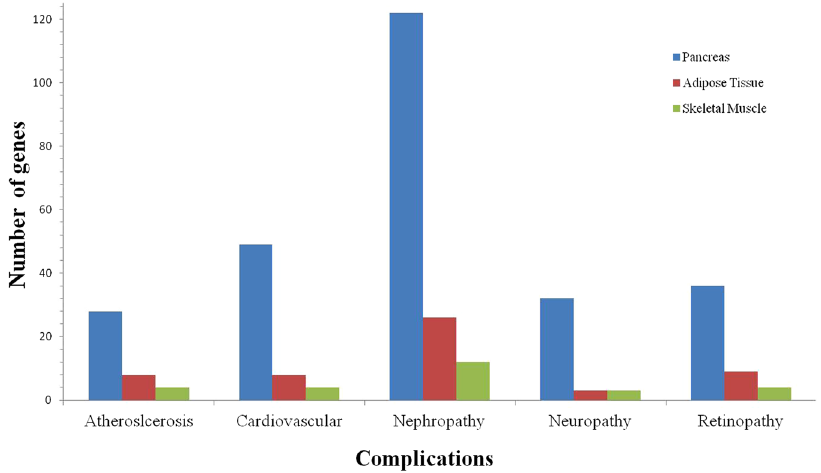
Figure 6. Number of differentially expressed genes with padj < = 0.05 in T2DM patient’s different tissues namely Pancreas, Skeletal muscle and Adipose